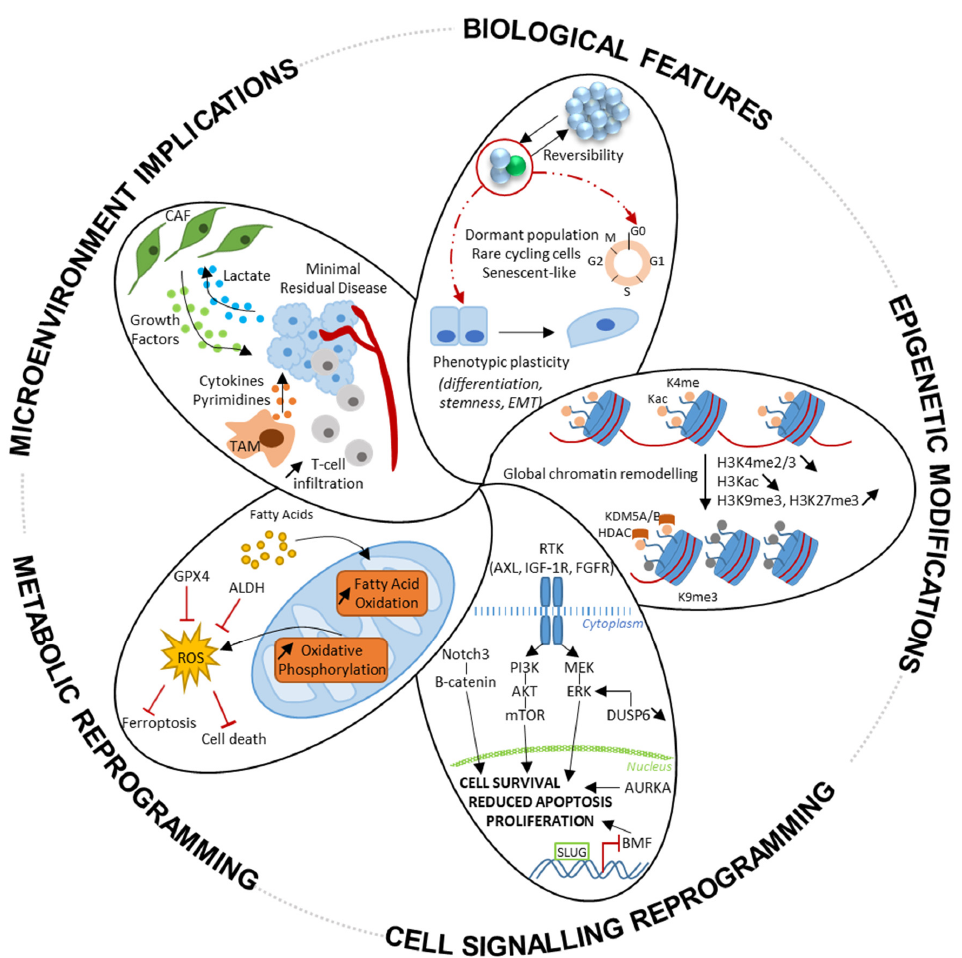
Figure 4. Hallmarks of drug tolerance. Drug-tolerant persisters (DTPs) share biological